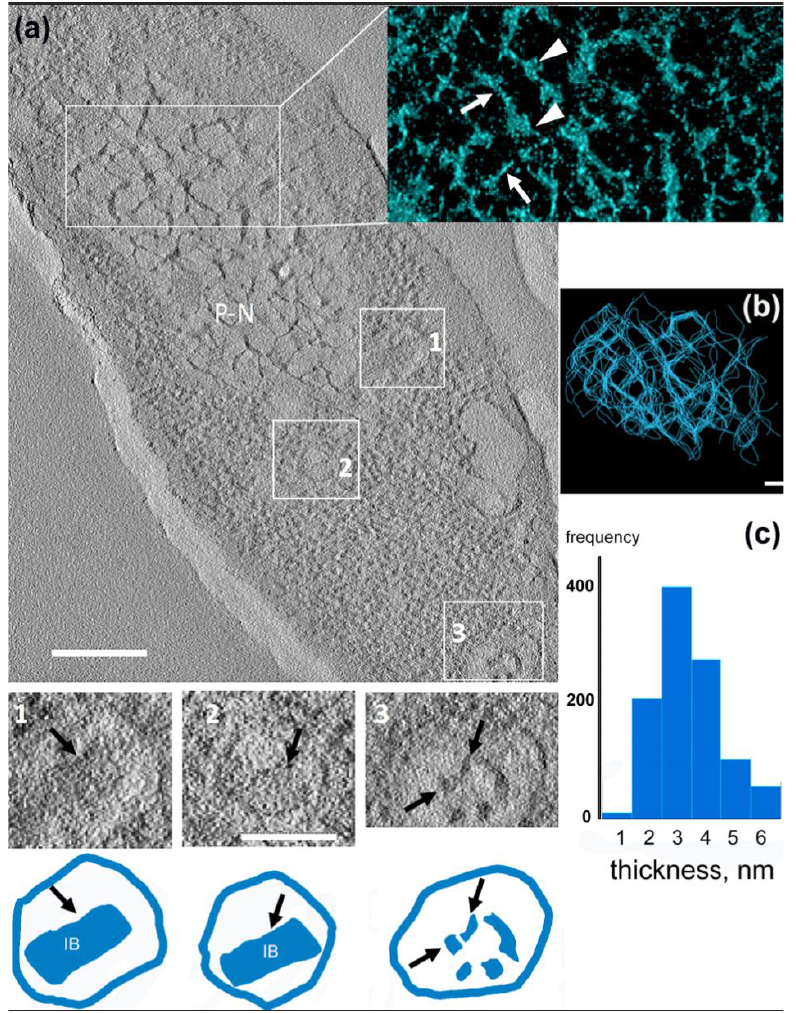
Figure 6. Electron tomography of a phiKZ infected P. aeruginosa cell. ( a ) A central slice through the tomogram of an infected cell (30 min after infection). Bar — 200 nm. P-N, pseudo-nucleus. Insert — 3D representation of the P-N network. White arrows are pointing to DNA strands, arrowheads — to phage DNA-binding proteins. The phage capsids and corresponding gallery images are labeled with rectangles one and two. Bar size — 100 nm. Below each gallery image is the matching schematic of the capsid with the inner body (IB) marked with a black arrow; rectangle three and the corresponding gallery image represent a RC. The electron-dense material is clearly visible inside (black arrows). ( b ) The subtomogram representation of the pseudo-nucleus network. Each blue strand represents one DNA helix. Bar—50 nm. ( c ) The distribution (in %) of the average DNA strand’s thickness in the pseudo-nucleus network.